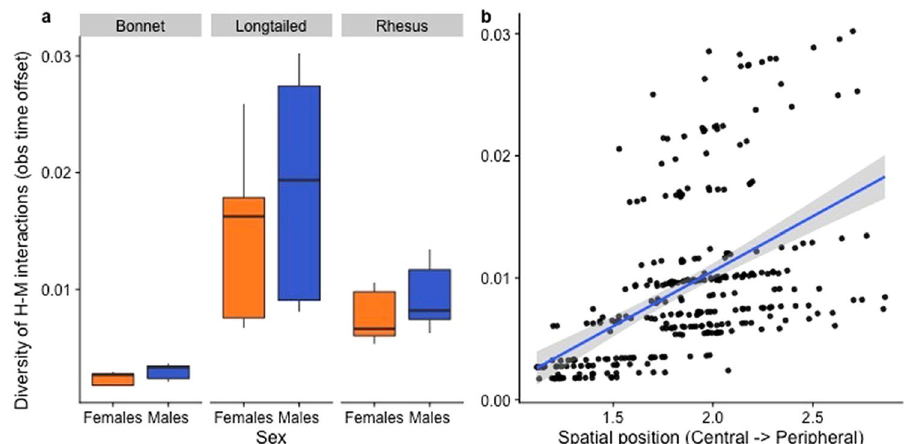
Figure 4. Effect of sex and species on the diversity of human–macaque interactions. As with Fig. 2, the second grouping in the scatterplot represents individuals from the long-tailed macaque groups from Batu Caves 43 . Figure was created using R (Version 3.6.1: https ://www.r-proje ct.org/).